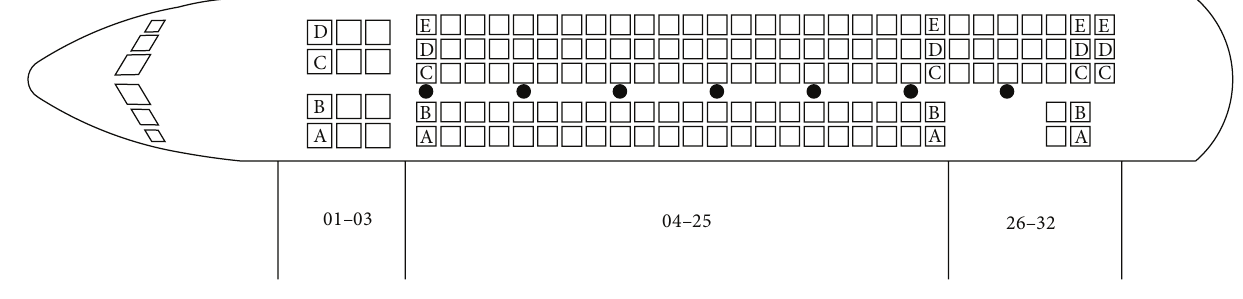
Figure 1: Cabin seat